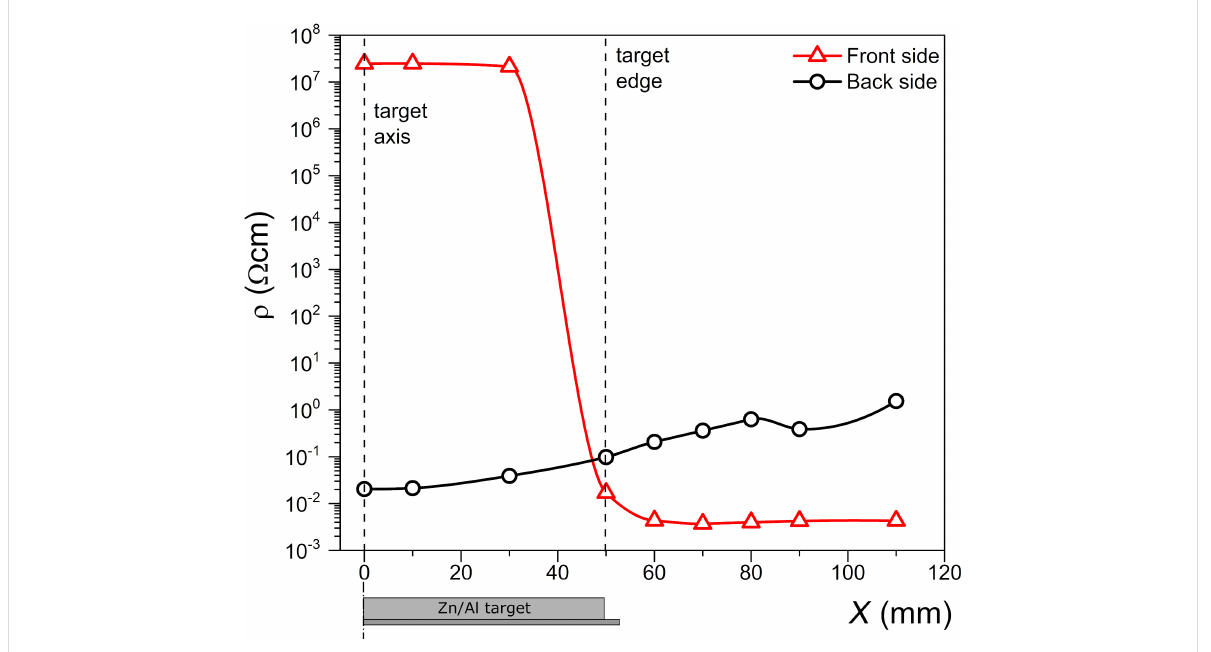
Figure 7: Distribution of the resistivity of thin films deposited on the front and back sides of the glass substrate as a function of the distance X from the Zn/Al target axis. The lines are to guide the eye.